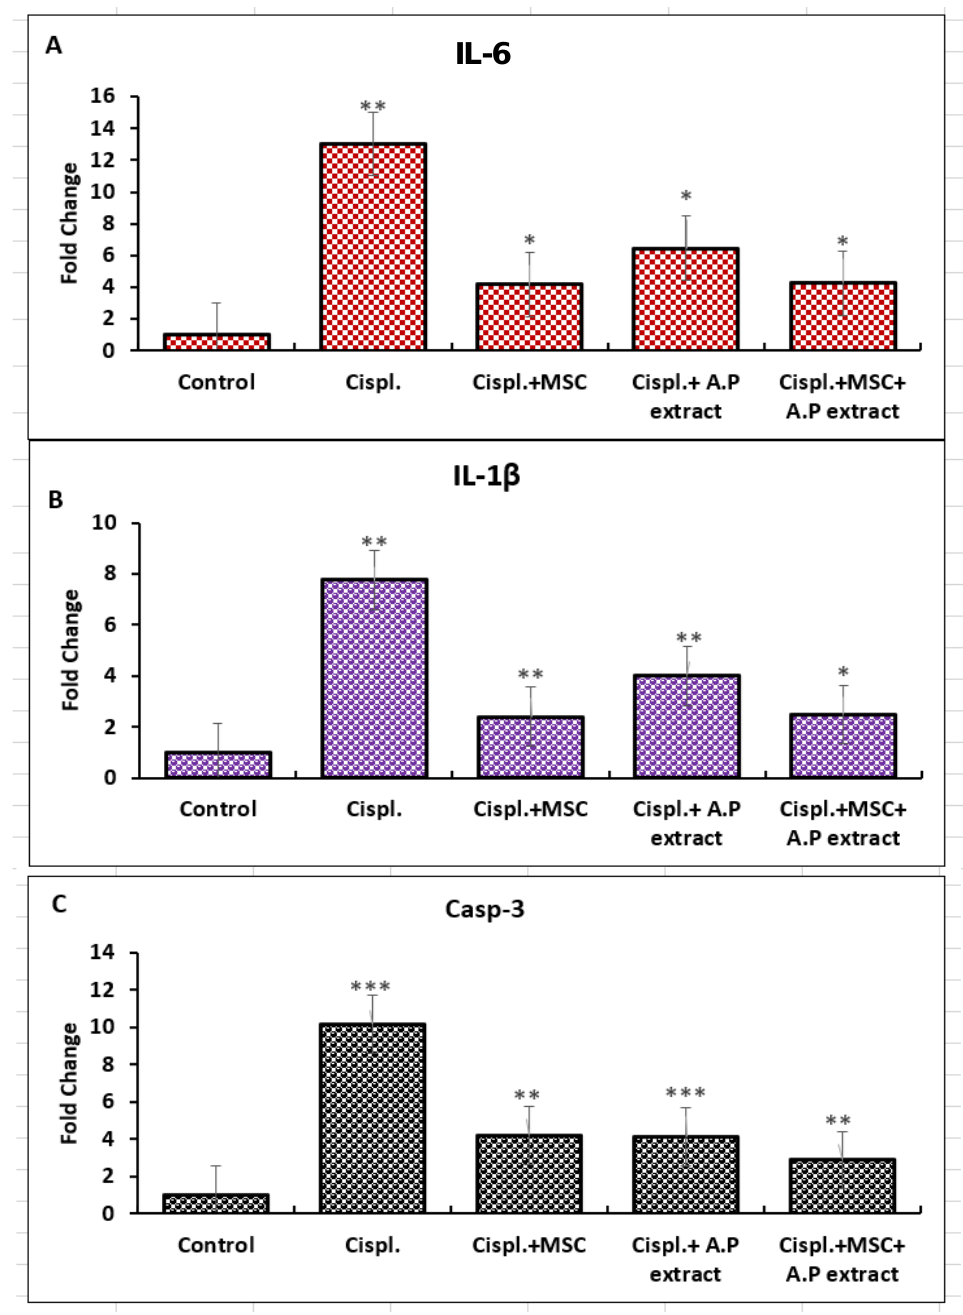
Figure 3. Gene expression profiles of IL-6, IL-1 β , and caspase-3. C: control, Cispl.: positive control, Cispl. + MSC: cisplatin with mesenchymal stem cells, Cispl. + A.P extract: cisplatin with Asian pigeonwing extract, Cispl. + MSC. + A.P: cisplatin with mesenchymal stem cells and Asian pigeon- wing extract. ( A ) IL-6, ( B ) IL- 1β , and ( C ) caspase-3. Values are shown as mean ± SD and ns ( p > 0.05), * ( p < 0.05), ** ( p < 0.01), *** ( p < 0.001) compared to the corresponding value in the control group.